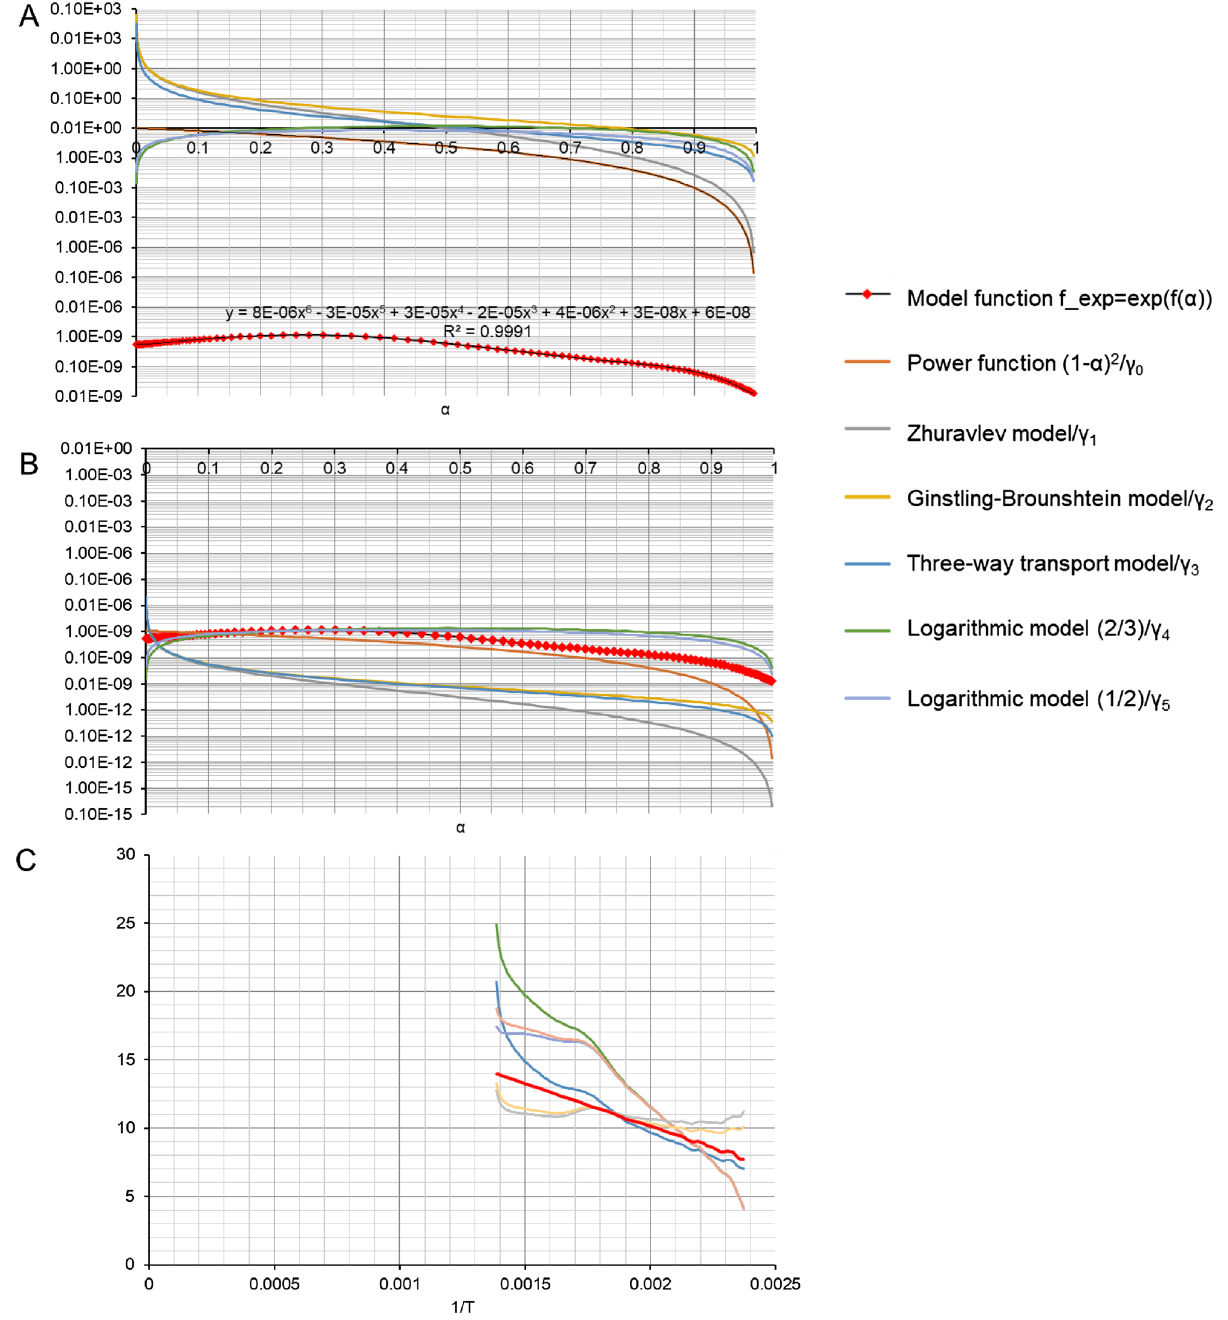
Figure 4. Comparison of the evaluated model f exp = exp( f (α)) with theoretical models on a semi-logarithmic scale for β = 2.5 ( A ); comparison of the evaluated function exp( f (α)) with other model functions, with the scaling factor || γ · f (α)- f model (α)|| 2 = min(γ) for β = 2.5, where γ 0 = 0.94191 × 10 7 , γ 1 = 0.32135∙10 10 , γ 2 = 0.32440∙10 10 , γ 3 = 0.16198∙10 10 , γ 4 = 0.86725 × 10 7 , γ 5 = 0.73319 × 10 7 ( B ); and graphs of ln[β( d α/ dT )/( f (α))]—the left-hand side of Eq. (12)—with the following functions substituted for f (α): the polynomial function evaluated in this study, and standard model functions multiplied by the scaling factor γ, for β = ′ ( α ) = dT Influence of random errors of measurement of T = T (α) on the derivative T d α . During ′ the thermal degradation process, the derivative T is a positive function; therefore, for an undisturbed (exact) temperature graph T = T (α), the slope of the tangent line is less than 90°, thus tan( T’ (α)) > 0—as shown in Fig. S11. Disturbance of T (α) by a random error (disturbed measurement points are marked in Fig. S11) may cause a situation where tan( T’ (α)) < 0, which does not correspond to the physics of the thermal degradation